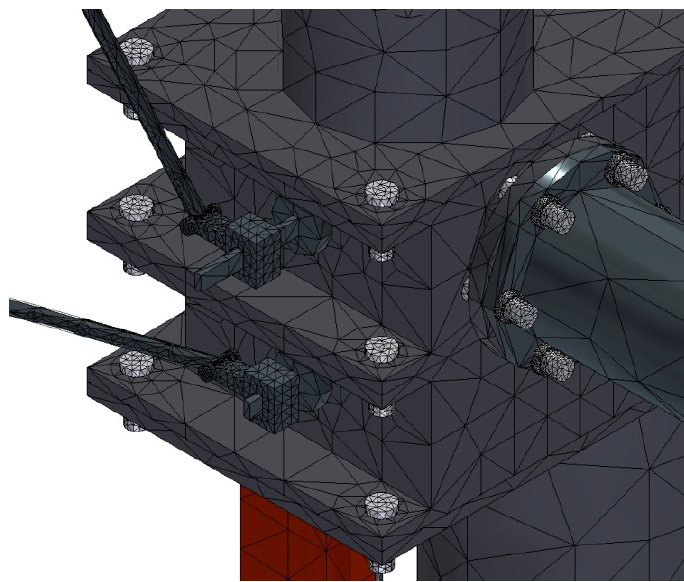
Figure 12. Refinement of the mesh in areas of complex geometry.